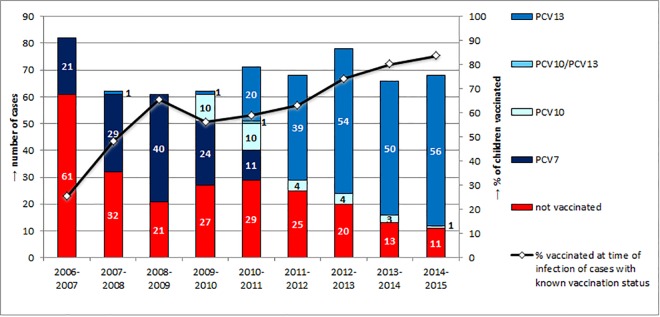
Vaccination status at time of infection of 618 children with IPD reported to the GNRCS from July 2006 –June 2015.Red: not vaccinated, dark blue: vaccinated with PCV7, light blue: vaccinated with PCV10, blue: vaccinated with PCV13. The black line represents the percentage of children vaccinated at the time of infection among the cases for which the vaccination status could be ascertained. Left Y-axis: number of cases, right y-axis: percentage of vaccinated children.